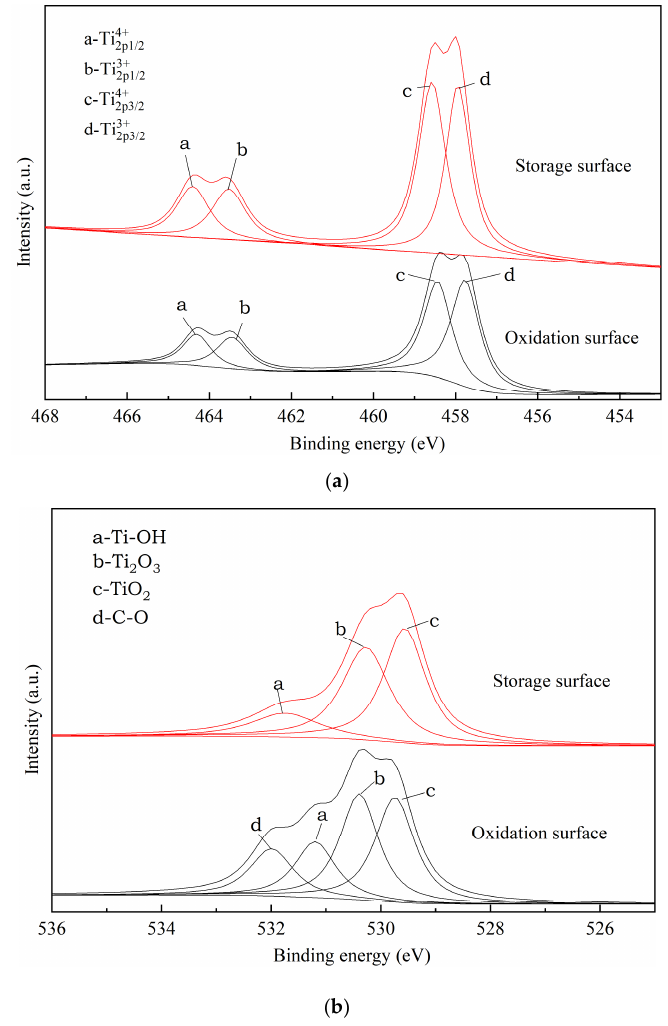
Figure 3. ( a ) Ti2p patterns and ( b ) O1s patterns on the oxidation surface of a Ti-sample before and after storage in alkali solution.